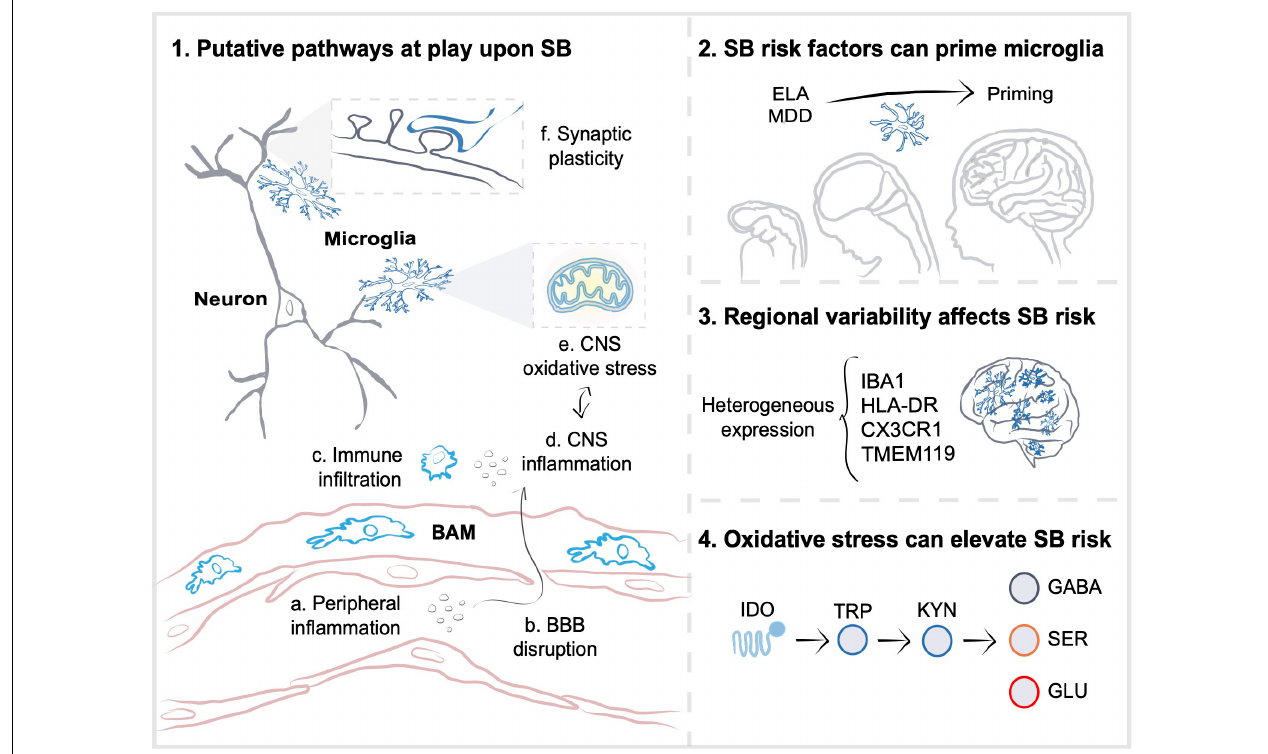
FIGURE 1 | Microglia participate in pathways altered upon suicidal behaviors. (1) As a result of stress-susceptibility, inflammation in the periphery (a) can contribute to blood-brain barrier (BBB) disruption (b) and infiltration of peripheral cells or border-associated macrophages (BAM) (c) to the central nervous system (CNS) parenchyma. Stress-induced inflammatory (d) and oxidative stress (e) molecules, such as cytokines, reactive oxygen species or adenosine triphosphate, work in a positive feedback loop that could affect microglial synaptic plasticity regulation (f), and increase suicidal behaviors (SB) risk. (2) SB risk factors, including distal early-life adversity (ELA) and proximal major depressive disorder (MDD), are associated with microglial priming, in which elevated expression of genes related to phagocytosis, cellular proliferation, and vesicular release result in exacerbated inflammatory responses upon exposure to subsequent challenges, as well as to impaired synaptic development and function. (3) The regional diversity of microglia possibly participates in determining susceptibility to inflammation induced by SB risk factors. Region-specific differences in gene or protein expression of ionized calcium-binding adapter molecule 1 (IBA1), major histocompatibility complex class II, DR (HLA-DR), CX3C chemokine receptor 1 (CX3CR1), transmembrane protein 119 (TMEM119), as well as in density are observed in post-mortem CNS samples from individuals who died by suicide. (4) Similarly, distinct CNS areas likely have different oxidative stress responses to inflammation. Oxidative stress induced by inflammation is thought to affect mitochondrial and tryptophan metabolism, which may lead to an increased activity of microglial indoleamine 2,3-dioxygenase 1 (IDO), an enzyme that breaks tryptophan (TRP) down into kynurenine (KYN). Increased KYN to TRP ratio could decrease serotonin (SER) and gamma-aminobutyric acid (GABA) signaling, whilst elevating glutamate (GLU) excitotoxity in individuals with SB. Altogether, the multiple synaptic plasticity-related pathways implicate microglia in SB, warranting further